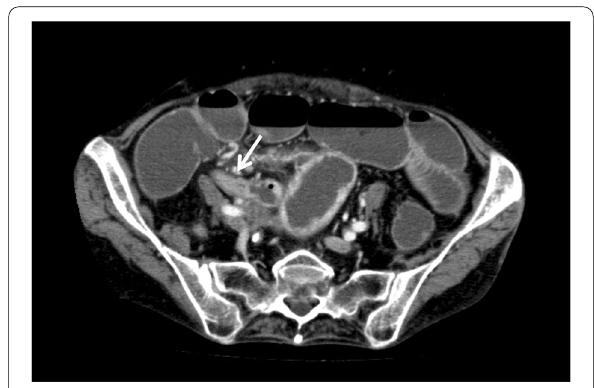
Fig. 3 Laparoscopy finding shows the telangiectasia of the terminal ileum serosa and an elastic hard mass-like lesion was palpable with laparoscopic forceps (white